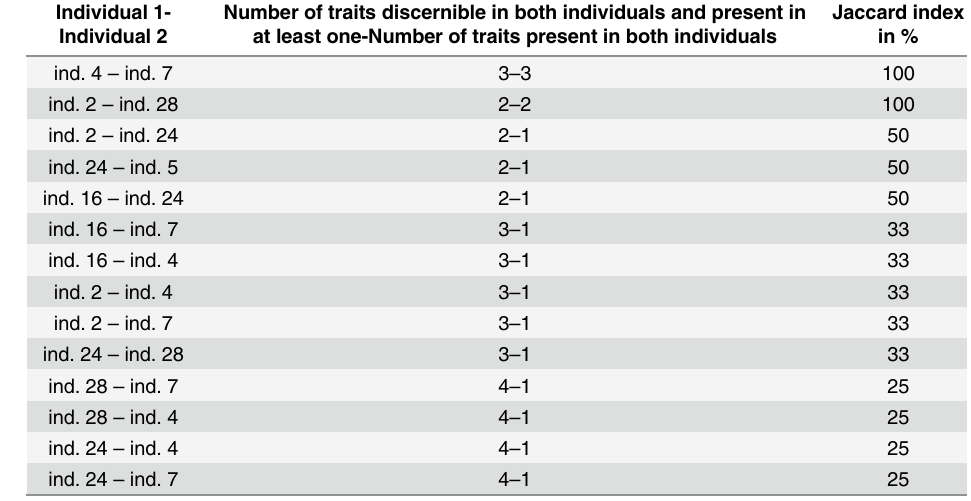
Table 4. Results of the search for pairwise